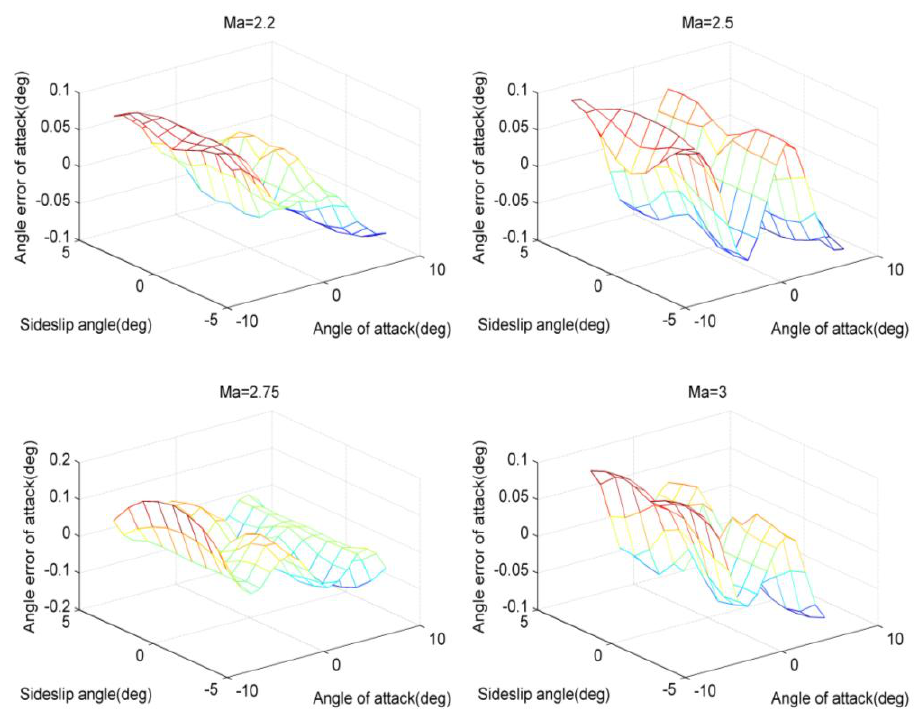
Figure 7. Change curves of angle errors of attack using look-up